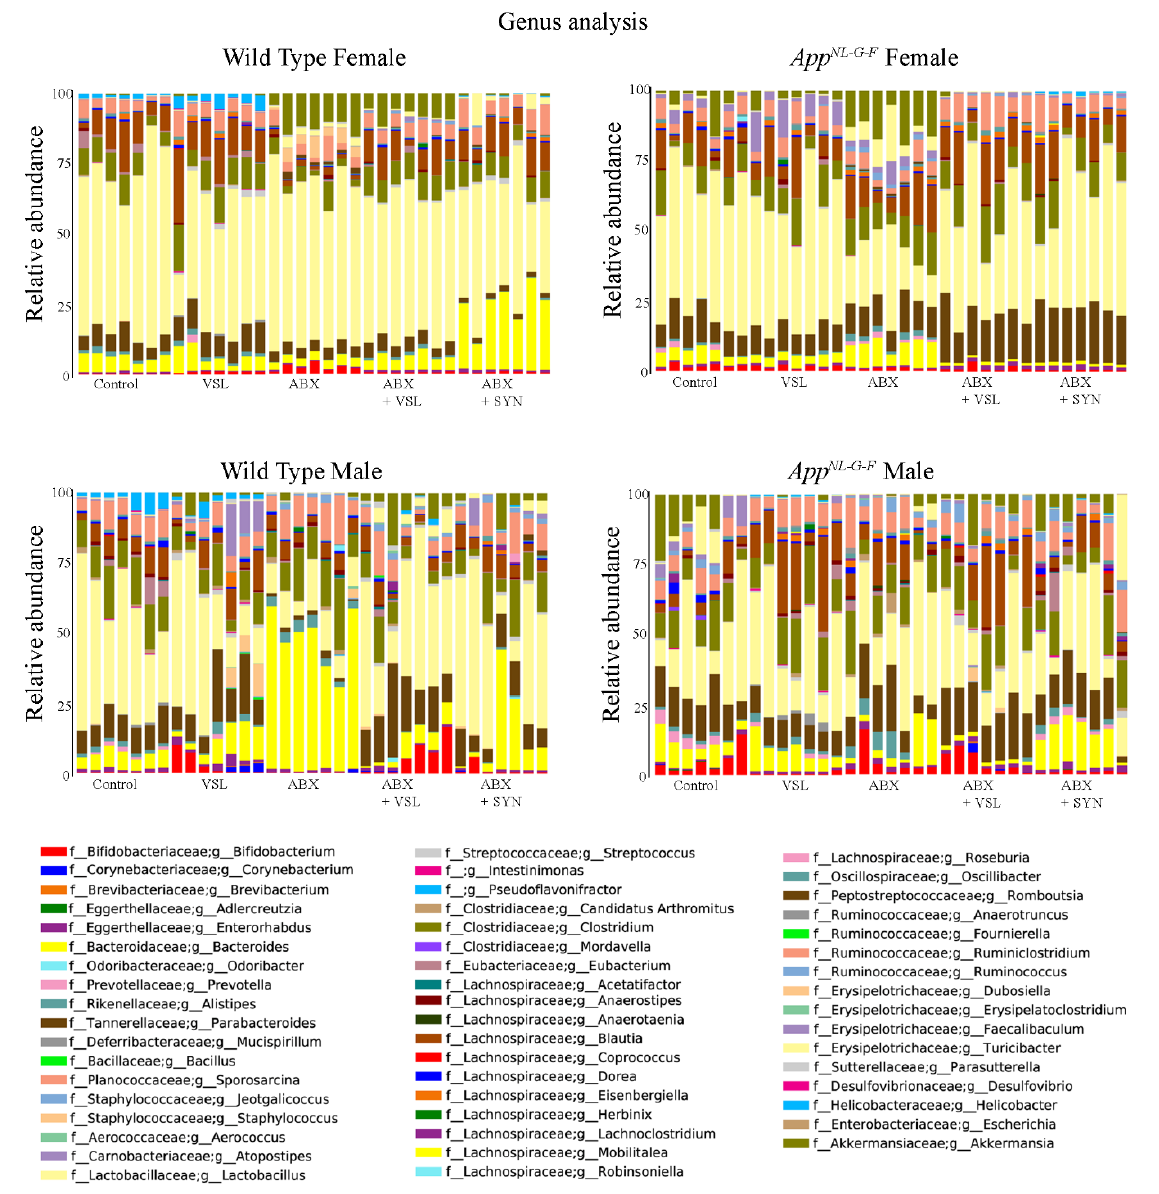
Figure 5. Effects of probiotic and antibiotics treatments on gut bacterial diversity in female and male mice. The relative abundance (%) of dominant bacterial genera in fecal samples of C57BL/6 (WT) and App NL-G-F mice treated with vehicle, VSL#3, antibiotics (ABX), antibiotics+VSL#3 (ABX + VSL), and antibiotics+VSL#3+prebiotic (ABX + Syn) are plotted as bar charts. The relative abundances are based on the proportional frequencies of the DNA sequences classified at the genus level. Seven animals per group were examined. Thus, each color represents a different bacterial genus.